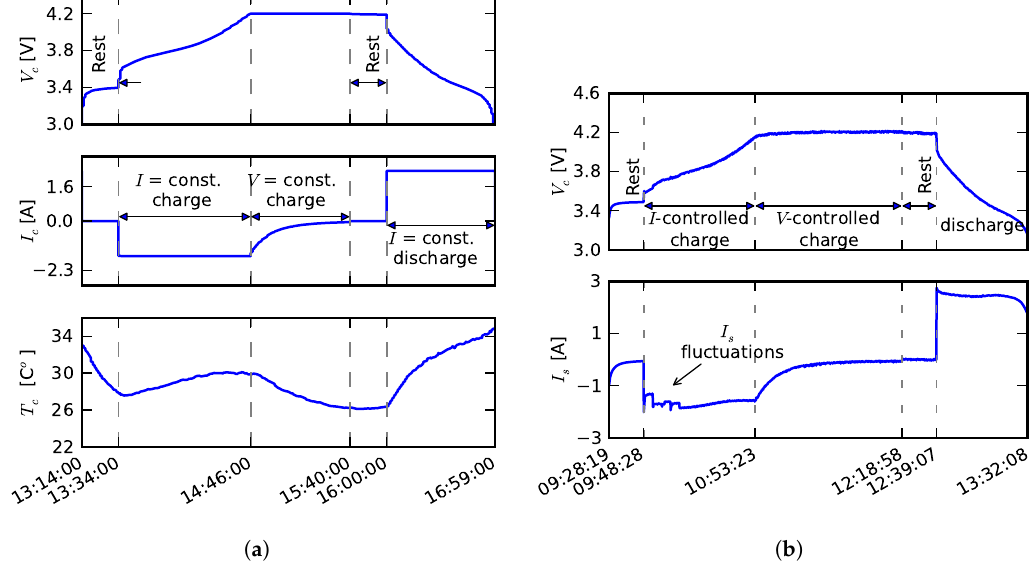
Figure 2. Waveforms associated with charge-discharge cycle ( a ) single-cell testing; ( b ) pack testing. To compare pack aging of cells with individual cell aging, we aged sixteen cells on the Maccor single-cell tester and nine cells in a pack. Figure 3a shows the capacity fade of individually aged cells vs. number of cycles, measured at discharge. Each of the sixteen cells was aged until its capacity faded to 90% of new (i.e., 10% capacity fade). The bottom plot of Figure 3a displays a histogram of number of cycles that led to 10% capacity fade. The average rate of capacity fade for the group of sixteen cells was computed from all the measurement points using the least mean squares, and the result ( 0.11%/cycle) is indicated in the plot. As shown in Figure 3b, capacity fade of cells aged in a − pack had a very similar degradation rate ( −